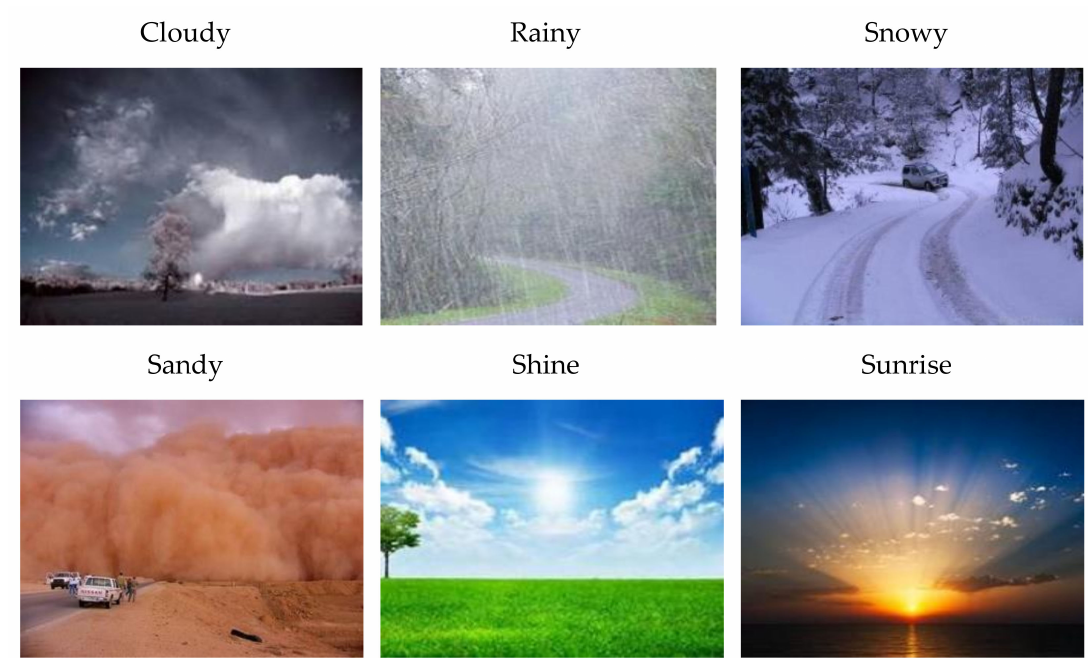
Figure 3. Sample images of different classes used in this work.